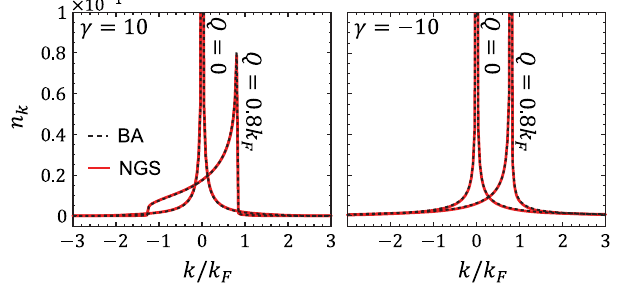
FIG. 6. Comparison of the impurity momentum distribution Q Þ : solid (red) curves correspond to simulations of function n k ð Eq. (A3); the BA results (dashed black lines) are taken from Ref. [47]. Parameters are the same as in Fig. 5.